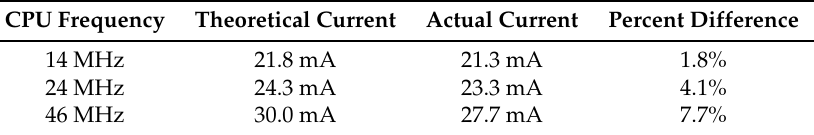
Table 2. CPU current drawn at different frequencies.